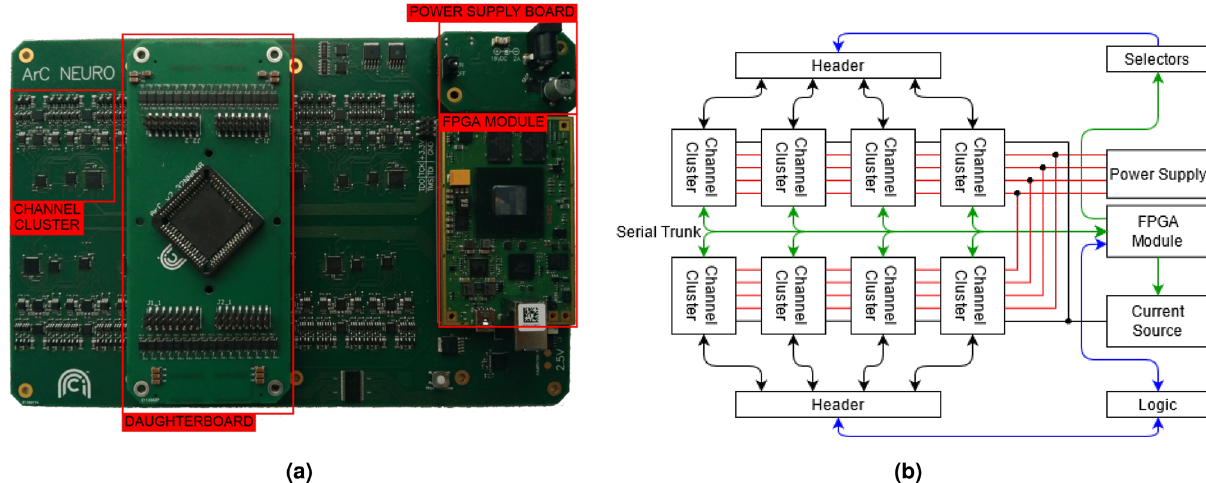
Figure 1. Overview of instrument. ( a ) Picture of fully assembled system PCBs, including base board, device- under-test interfacing daughterboard, FPGA dev board and power supply board. ( b ) High-level block diagram of system architecture illustrating parallelism and modularity of the system. Analogue connections are shown in black, serial connections are shown in green, parallel connections are shown in blue, and power supply connections are shown in